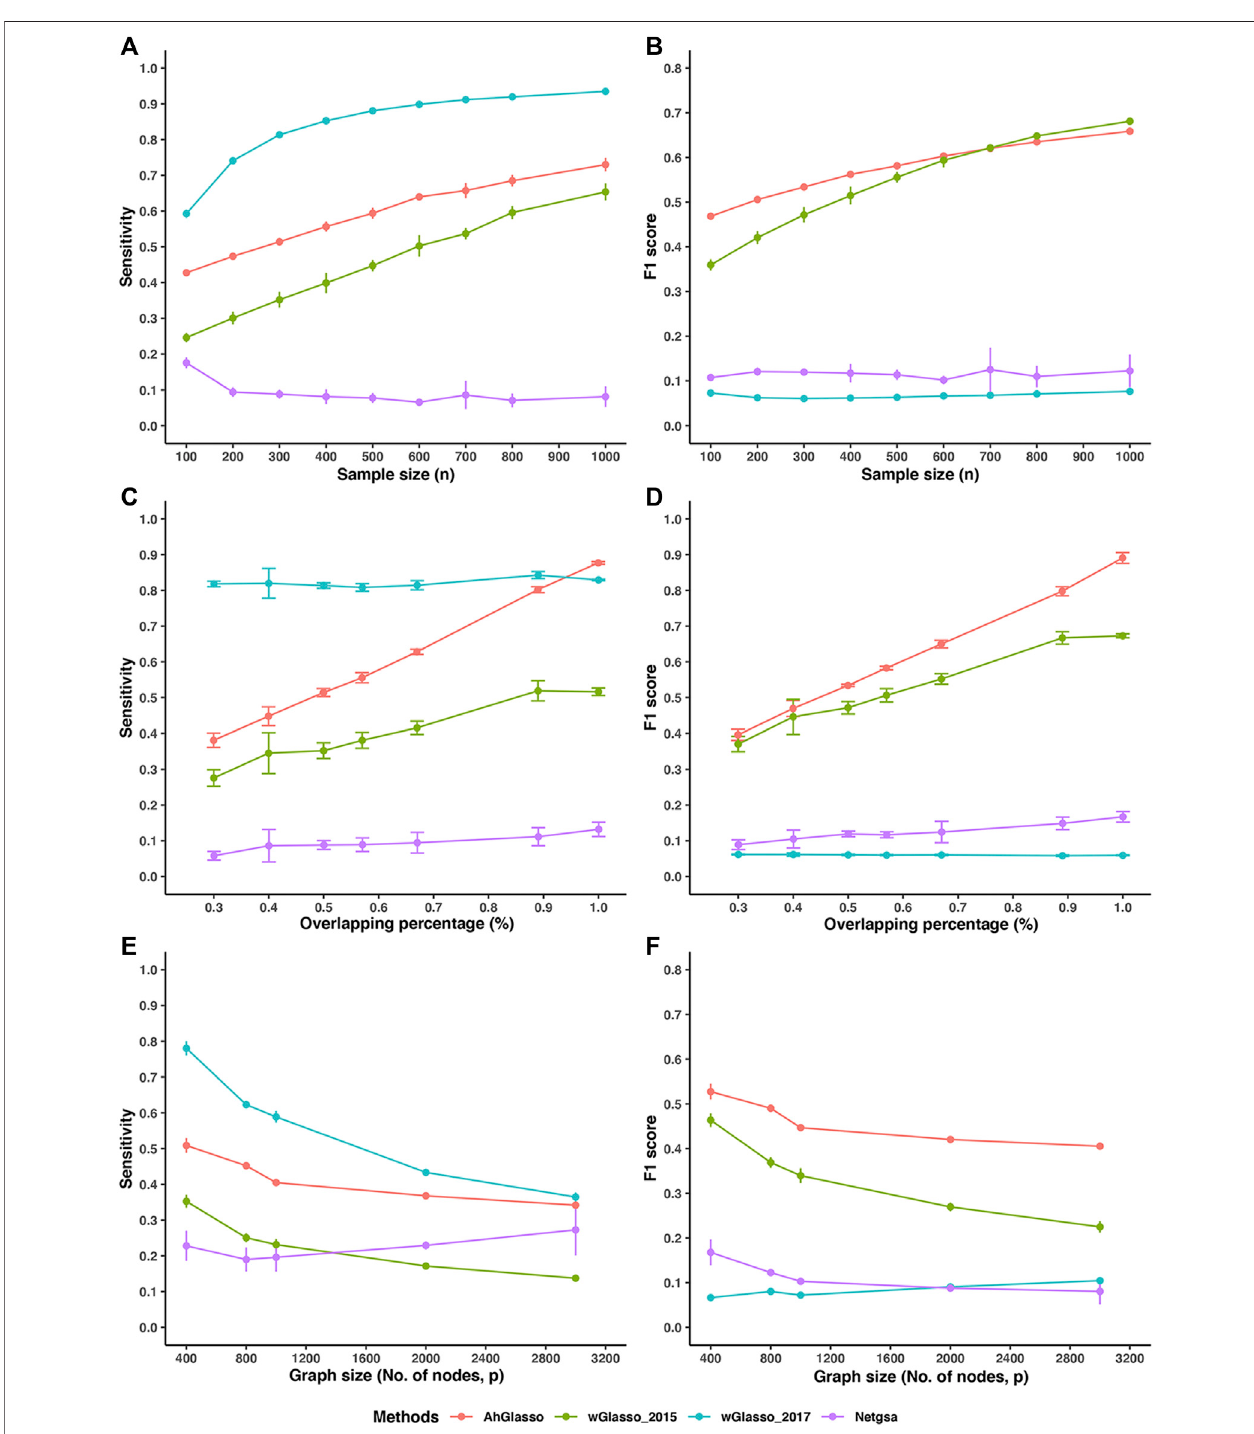
FIGURE 4 | Method performance comparisons. The simulated protein network graph included 1000 ( p ) nodes. The density of the simulated graph is around 4 % . (A – B) Theoverlappingbetweenprior informationand target true network is50 % . Avariety ofsamplesizes ofdatawas simulated asshown in X-axis.With the same true network and its corresponding covariance matrix ( Σ true ), we created various sizes ( n ) of multiple normal expression data for testing. We estimated the true network topology by using two weighted graphical Lasso (wGlasso_2015 and wGlasso_2017), Netgsa, and the proposed AhGlasso methods. The sensitivity (A) and F1 score (B) were calculated based on the estimated network and true network. (C – D) A variety of overlapping between prior information and target true network was simulated as shown in X-axis. The sample size was fi xed at n (cid:1) 300. The sensitivity (C) and F1 score (D) were calculated based on the estimated network and true network. (E – F) We investigated the effect of different graph sizes (p ranges from 400 to 3000) with a fi xed sample size ( n (cid:1) 100) and the overlapping between prior networkand target network(50 % ).Thesensitivity (E) andF1 score (F) werecalculated aspreviously. Foreach simulationsetting, thesimulationswererepeated 5times. The lines represent the mean scores for the simulated sample size and the error bars represent the standard error of the mean for each method.